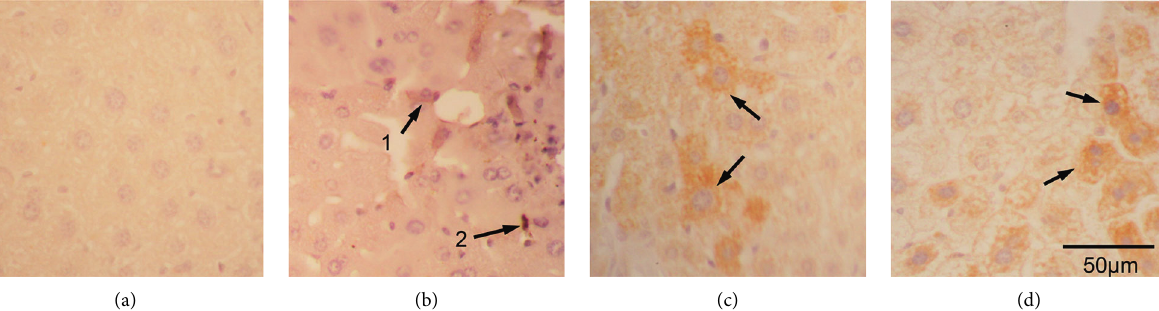
Figure 5: Activated caspase-3-positive cells in the saline- (a), ethanol- (b), fluoxetine- (c), and atorvastatin-treated (d) liver. Arrows denote positive cells; 1 denotes a positive liver cell; and 2 denotes a Kupffer cell,